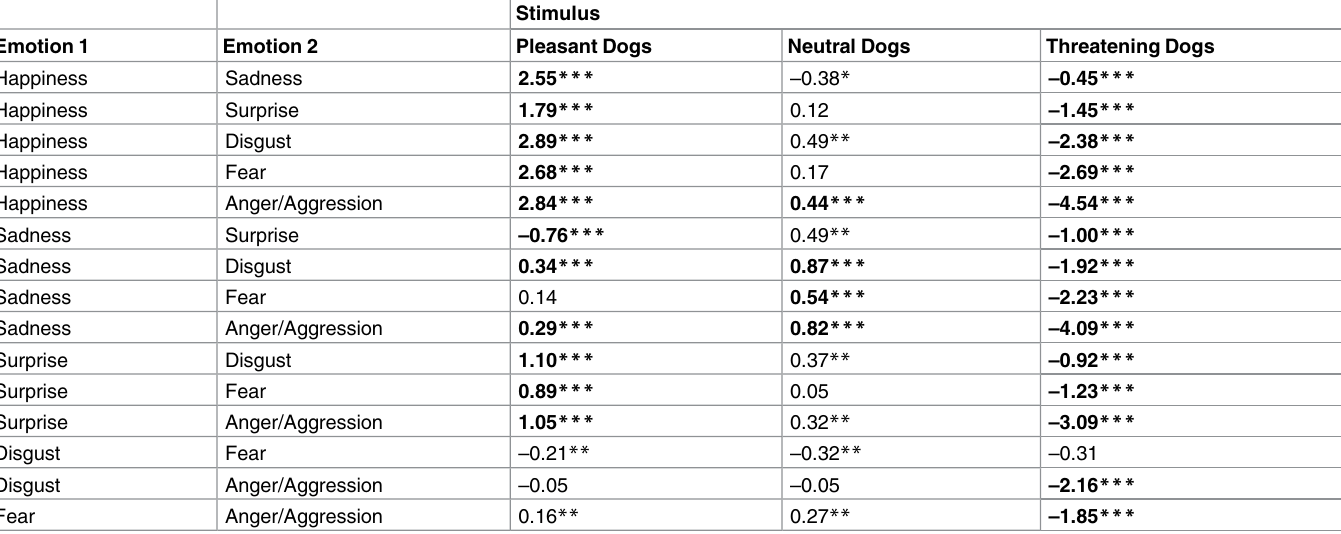
Table 1. Differencesof emotion ratings within dog expressions. Plannedcomparisons of the subjectratings of discreteemotions(Emotion 1 vs . Emotion 2) for each of the dog expressioncategories. Significantdifferences are marked on the beta values with asterisks ( * p < 0.05, ** p < 0.01, *** p < 0.001) and the results with p-values abovethe FDR threshold are written in bold type.